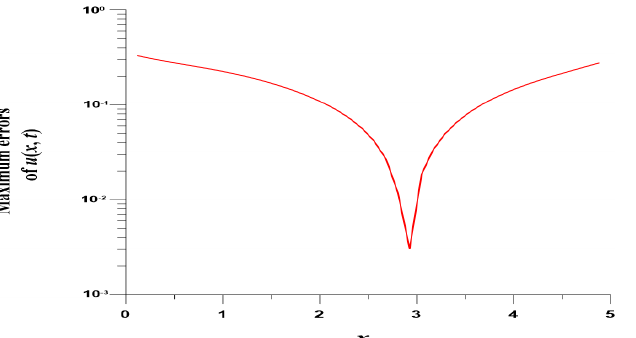
Figure 15. For Example 9 of the backward nonlocal wave problem under two-side nonlocal BCs: ME( u ) versus x in the spatial interval.